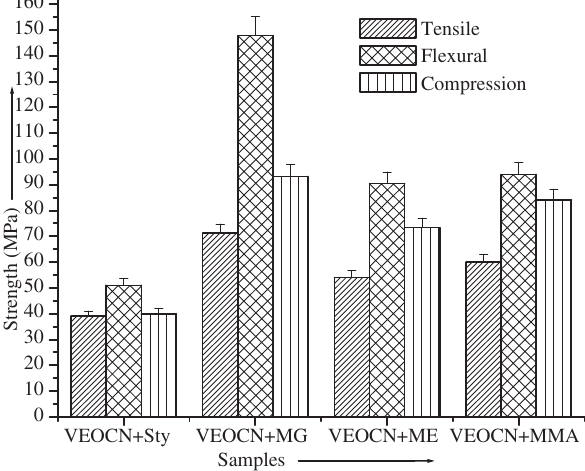
Figure 9: The values of tensile, flexural and compression strengths of VEOCN samples containing styrene, MMA, MG and ME as reactive